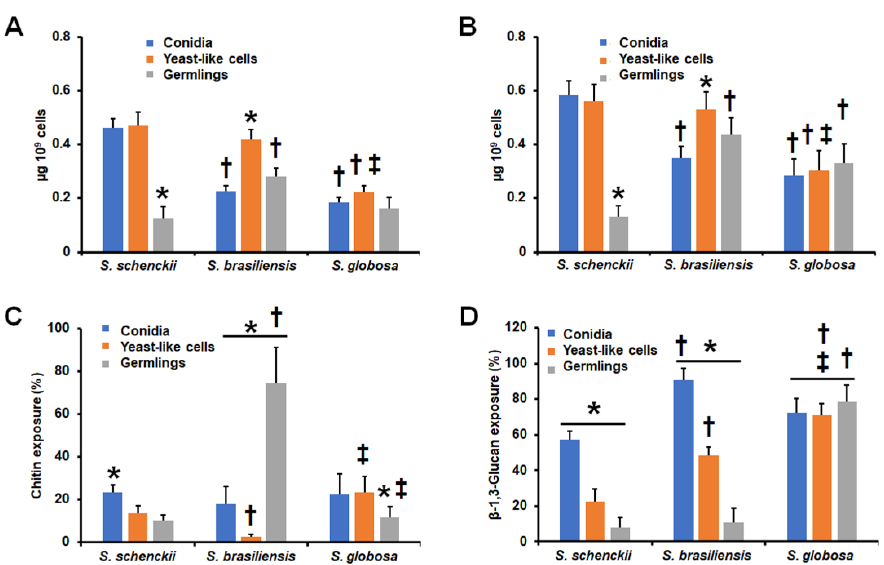
Figure 1. Cell wall analysis of the di ff erent Sporothrix schenckii , Sporothrix brasiliensis , and Sporothrix globosa morphologies. In ( A ), cells were treated with 25 U of endoglycosidase H for 20 h at 37 °C and the released N -linked glycans were quanti fi ed by high-performance anion-exchange chromatography with pulsed amperometric detection (HPAEC-PAD). In ( B ), cells were treated overnight with 0.1 N of NaOH, and the trimmed O -linked glycans were saved and quanti fi ed by HPAEC-PAD. Cells were stained with 1 mg mL − 1 of wheat germ agglutinin- fl uorescein isothiocyanate (panel ( C )) or with 5 µg mL − 1 of IgG Fc-Dectin-1 chimera, and then with 1 µg mL − 1 of donkey anti-Fc IgG- fl uorescein (panel ( D )) to stain chitin and β -1,3-glucan, respectively. The fl uorescence of 300 cells for each condition was calculated and the median fl uorescence was estimated as previously. The 100 % fl uorescence corresponds to that calculated in heat-killed cells. fluorescence corresponds to that calculated in heat-killed cells. S. schenckii — Sporothrix schenckii ; S. brasiliensis — Sporothrix brasiliensis ; S. globosa — Sporothrix globosa . Results are the median ± standard deviation from three independent experiments performed in triplicate. * p < 0.05 when compared to other morphologies from the same species; † p < 0.05 when compared to the same morphology in the other two fungal species; ‡ p <0.05 when compared to the same morphology in S. brasiliensis